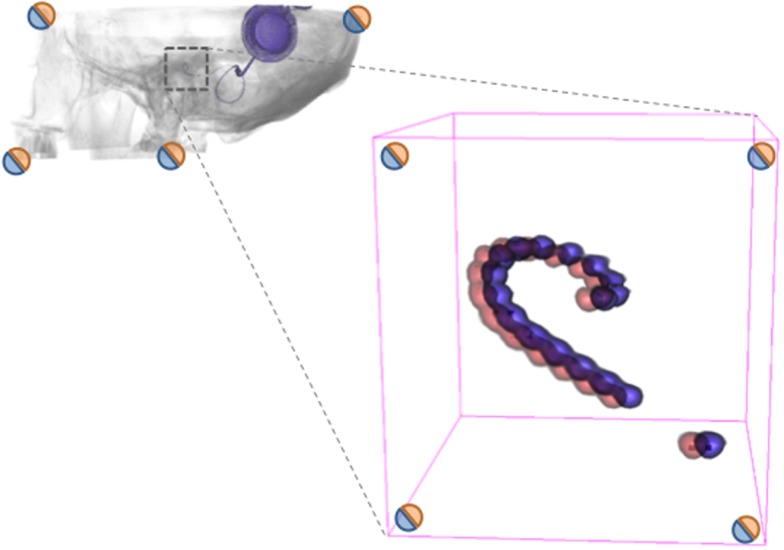
Illustration of CI migration assessment. When two volumes (CBCTs) are successfully fused using an accurate registration, the area of interest can be inspected for changes using volumetric rendering. In this exemplary imaginary case, there is a migration of the CI. Since the fiducials (corners) indicate the success of registration (as measured), one can establish the accuracy of the measurement of migration. The goal of the current investigation is to measure the distances between fiducials, so that it is possible to accurately determine the difference in CI electrode position, hence migration of the CI electrode.